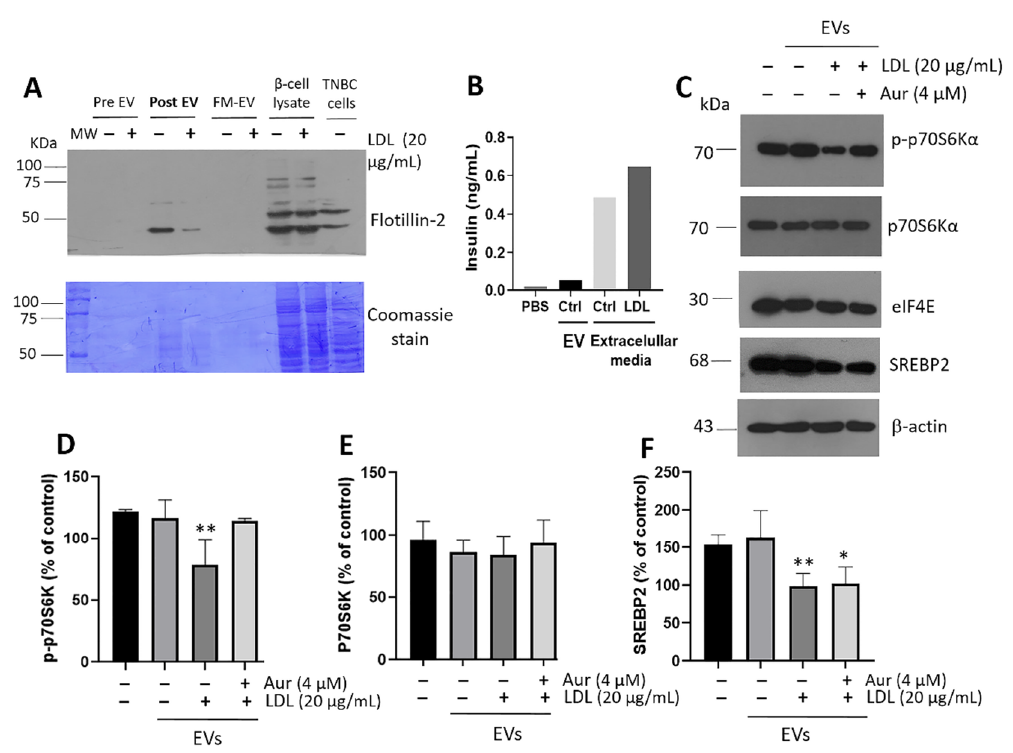
Figure 8. The effect of extracellular vesicles (EVs) in β -cells on insulin signaling in hepatocytes. ( A ) Characterization of the purity of EVs isolated in extracellular media of β -cells was carried out through several steps; flotillin-2 was used as a marker. Pre-EVs: extracellular vesicles at 0 h; Post-EVs: extracellular vesicles at 20 h; FM-EVs: free medium of extracellular vesicles. β -cells and triple- negative breast cancer cells (TNBC) lysates were used as controls. In addition, Coomassie stain was performed on PVDF membranes. ( B ) Insulin quantification in EVs samples and extracellular media of β -cells employing the ultrasensitive insulin ELISA assay. ( C ) Characterization of insulin signaling in hepatocytes by p-p70S6k α , p70S6k α , eIF4E, and SREBP2 under the treatment of EVs derived from β -cells incubated with LDL (20 µ g/mL) and concomitant Aur (4 µ M) treatment, respectively. PBS was used as a control. Densitometry analysis of p-p70S6k α ( D ), p70S6k α ( E ), and SREBP2 ( F ). Results are reported as mean ± SD ( n = 3) and expressed as % of control, * p < 0.05, ** p < 0.01.